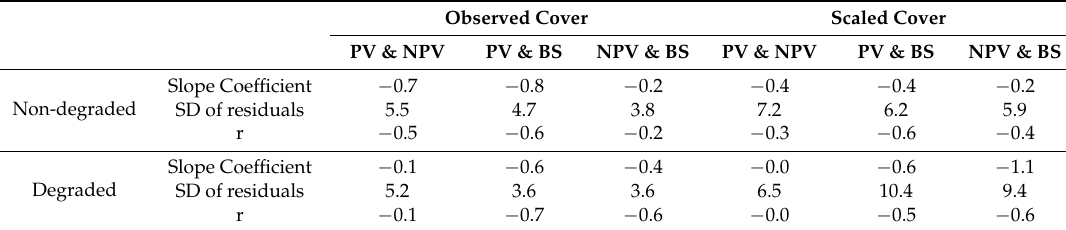
Table 7. Slope and correlation coefficients and standard deviation of residuals from linear regression between each component of fractional cover; photosynthetic vegetation (PV) cover, non-photosynthetic vegetation (NPV) cover, and bare soil (BS) cover identified as degraded and non-degraded by scaled NPP. Scaled components of fractional cover are also presented. See Table 2 for the significance of correlation coefficients ( r ).